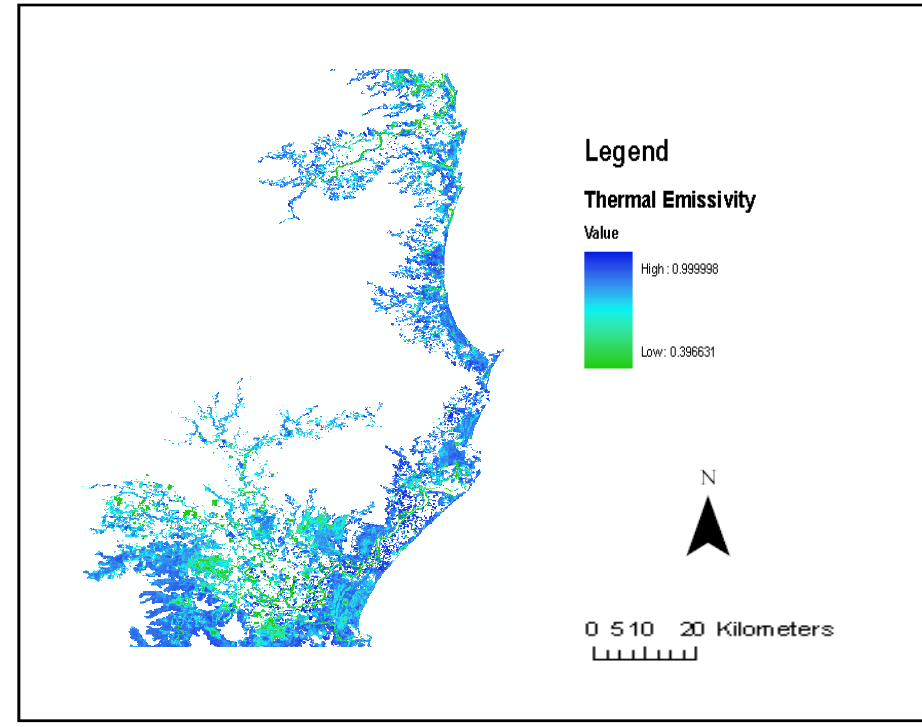
Figure 9. Thermal emissivity values for the wetland